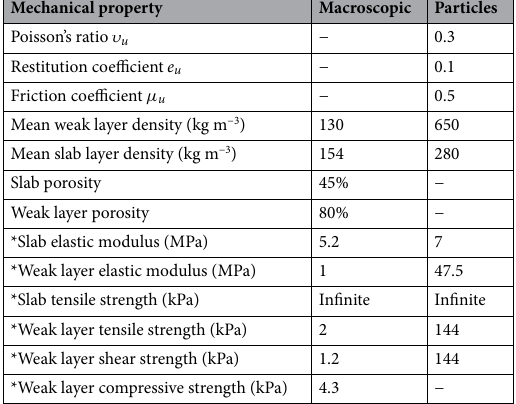
Table 2. Mechanical properties of DEM model. An asterisk (*) indicates those properties that were selected by optimizing the agreement between experiment and simulation.